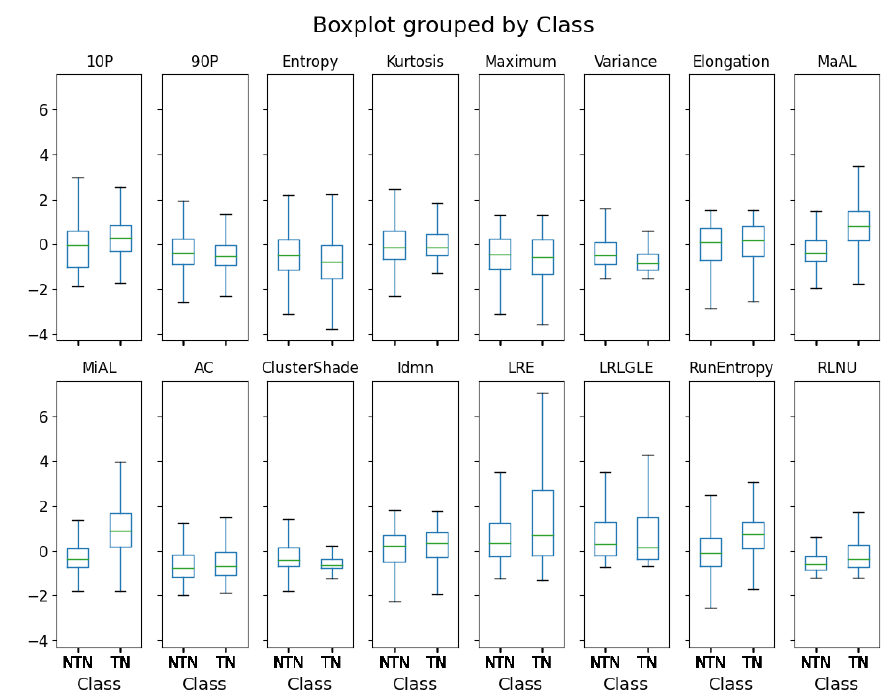
Figure 9. Boxplots for the selected features. NTN stands for non-tumor nucleus; TN stands for tumor nucleus; 10P stands for 10Percentile ; 90P stands for 90Percentile ; MaAL stands for MajorAxisLength ; MiAL stands for MinorAxisLength ; LRLGLE stands for LongRunLowGrayLevelEmphasis ; RLNU stands for RunLengthNonUniformity ; AC stands for Autocorrelation ; LRE stands for LongRunEmphasis . All of the selected features show statistically significant differences according to the Mann–Whitney U